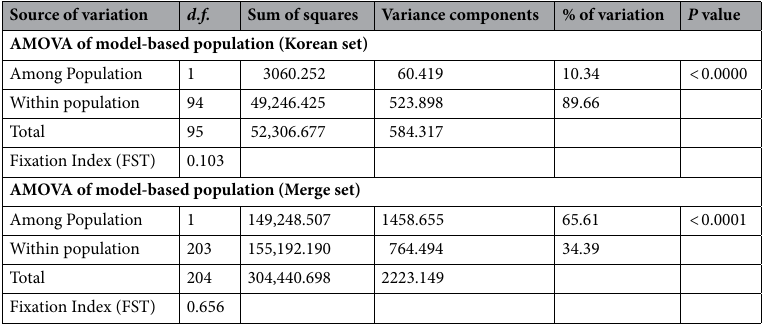
Table 2. Analysis of molecular variance (AMOVA) among and within the populations of Korean set and Merge get of peanut genotypes (df: degree of freedom; %, Percentage).